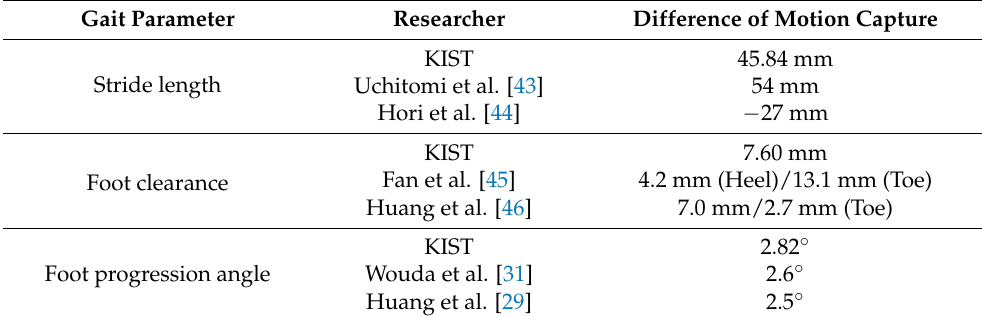
Table 3. Mean gait parameter difference of motion capture compared with other